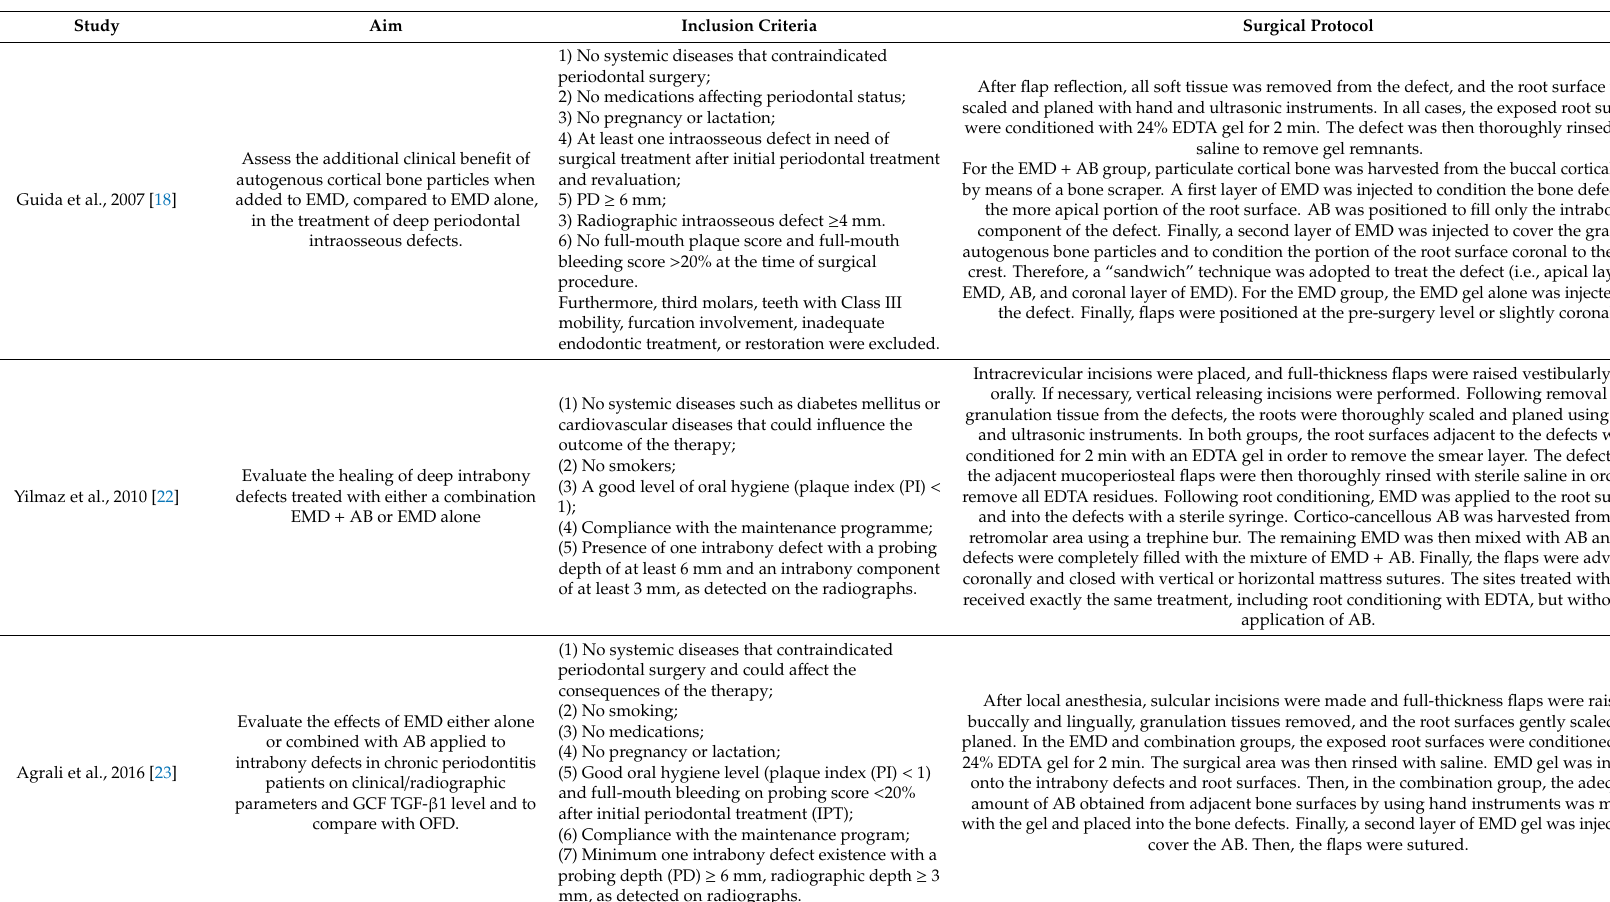
Table 2. Main characteristics of selected studies: aim, inclusion criteria, and surgical